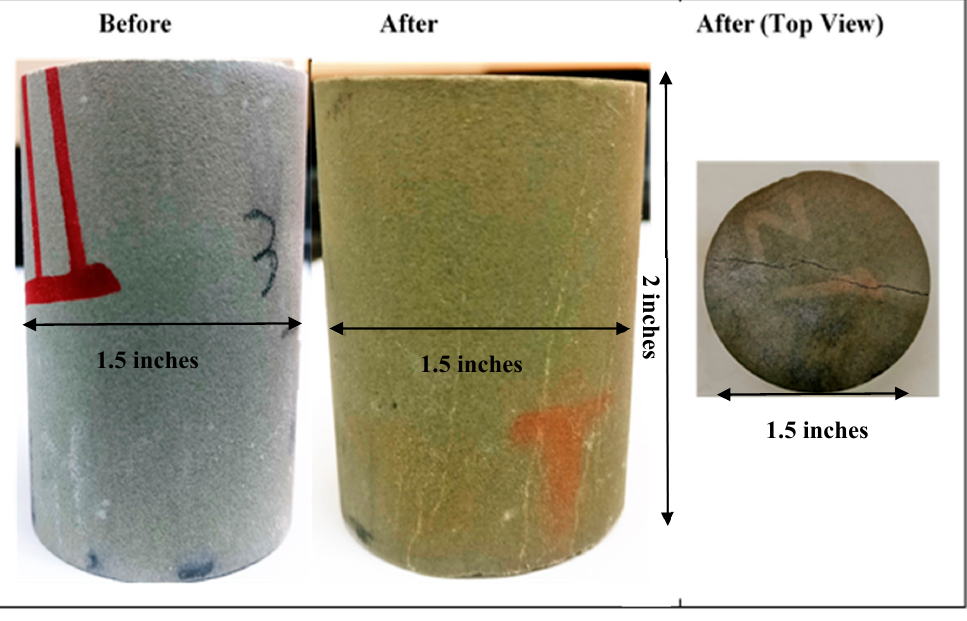
Figure 7. Images for the core samples before and after the thermochemical injection. Energies 2018 , 11 , x FOR PEER REVIEW